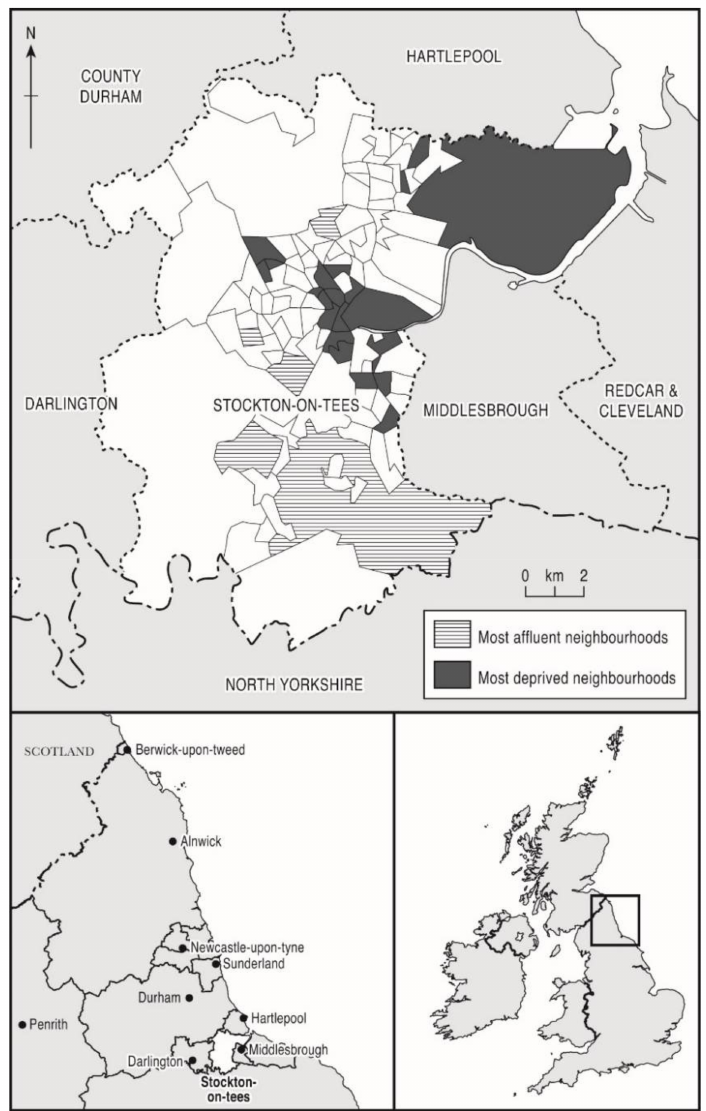
Figure 1. Maps of Stockton-on-Tees showing most- and least-deprived